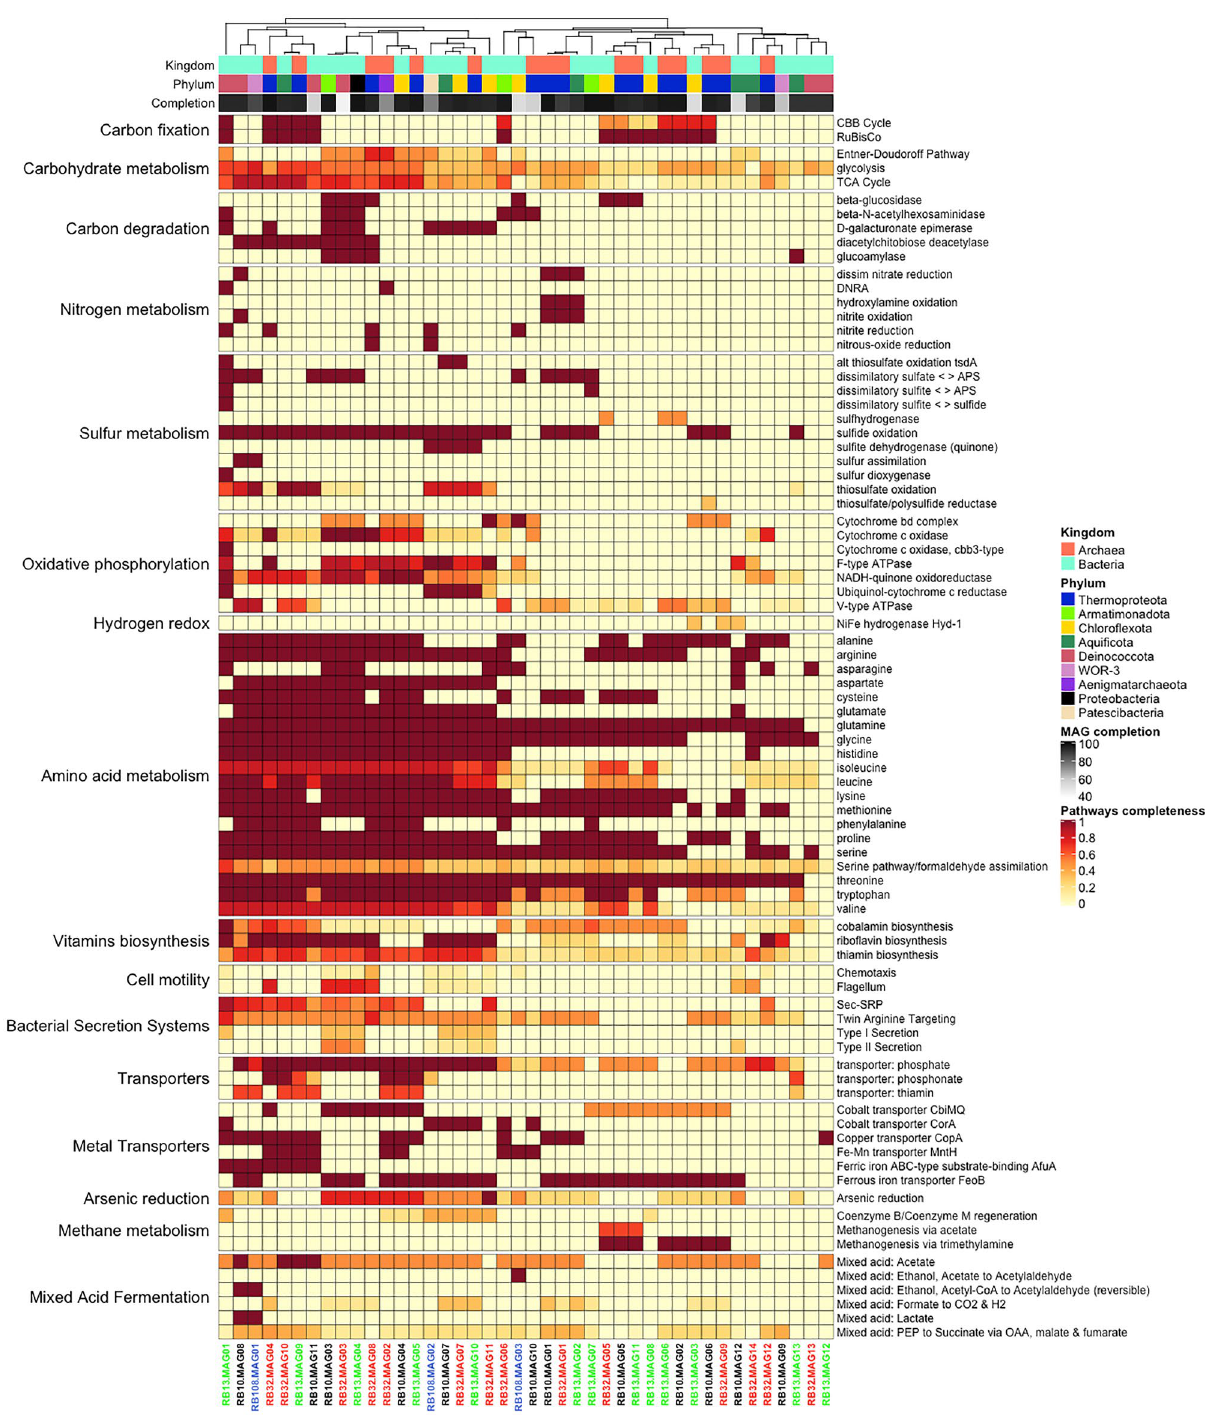
Figure 3. Metabolic pathway diagram of the 42 MAGs based on KEGG Decoder annotations, showing MAG classification according to GTDB-Tk and estimated genome